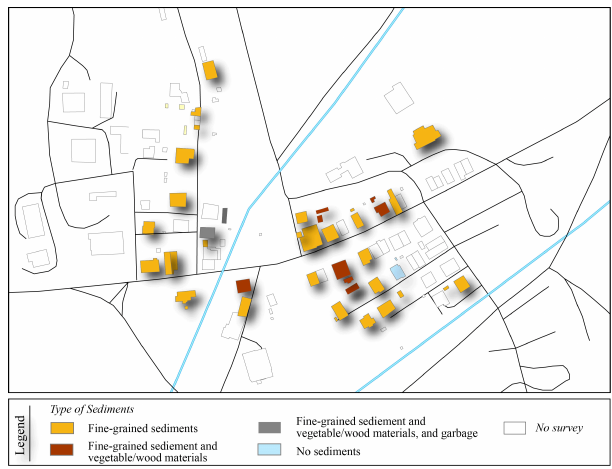
Fig. 6. Sediments in the surveyed buildings in Città della